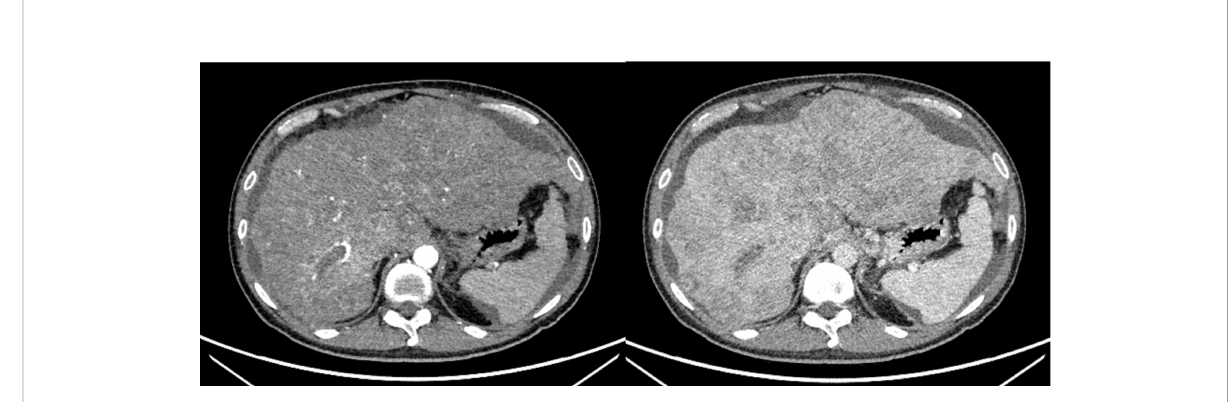
FIGURE 1 The preoperative CT images of the